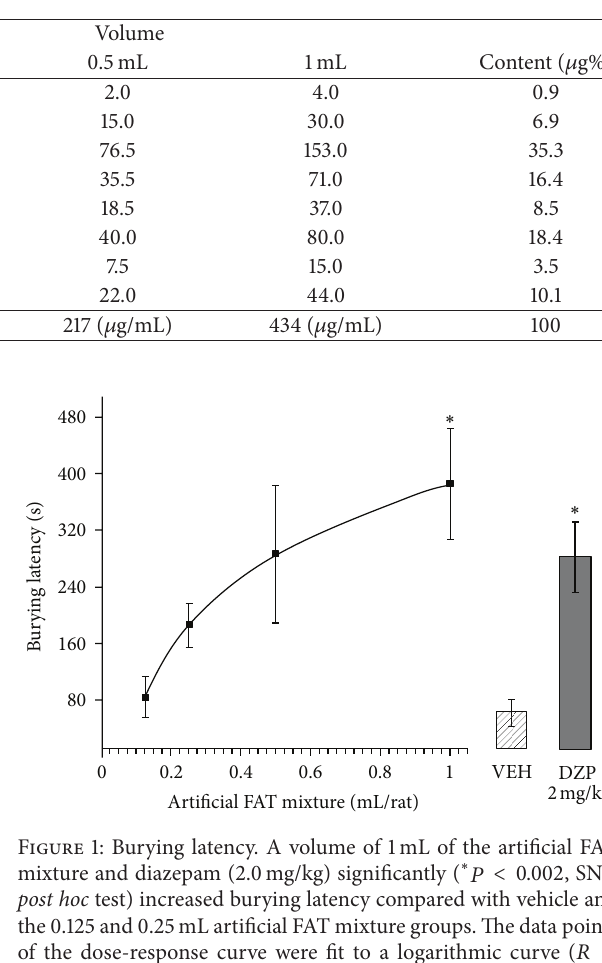
Table 1: Fatty acid concentrations contained in volume administered to each rat. The fatty acid concentrations contained in 1mL of the artificial FAT mixture correspond to the proportion found in human amniotic fluid [14, 24].